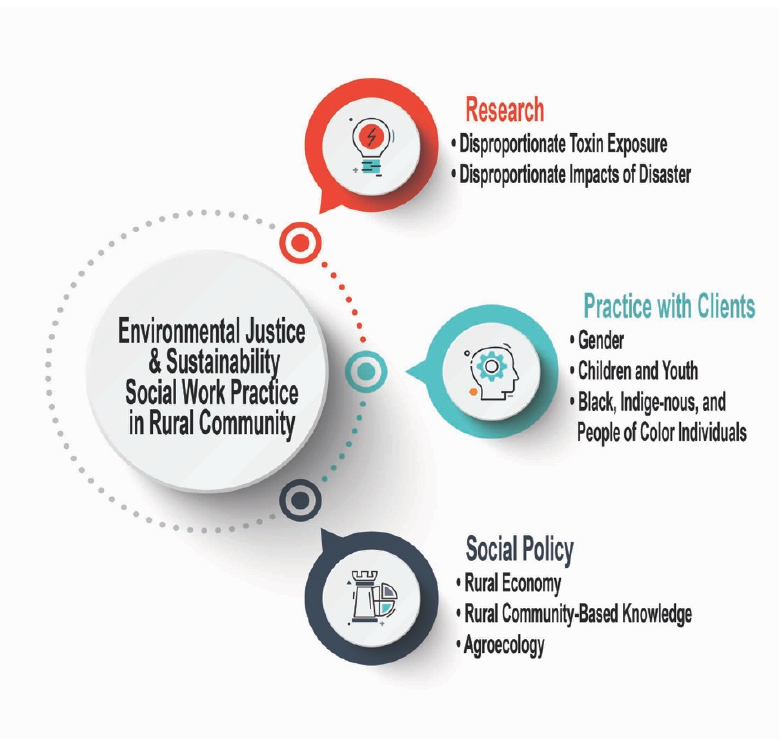
Figure 2. Data Analysis Structure.